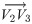
Directional derivatives along V2V3→.